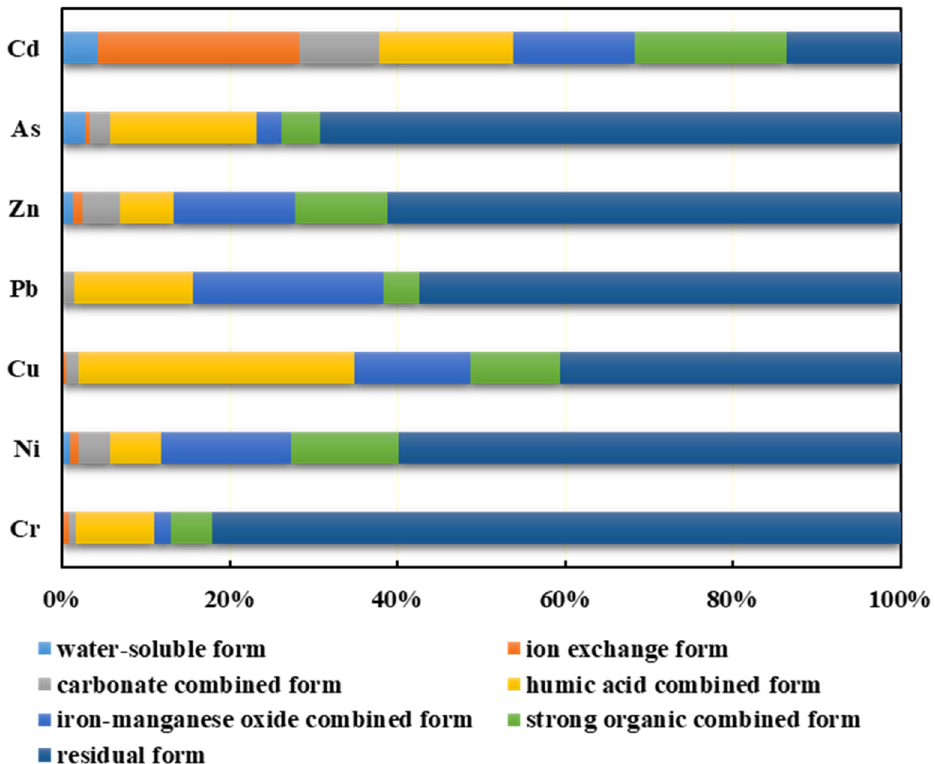
Figure 2. The proportion chart of different forms of heavy metals in the farmland soil around the Dachang mining area. Table 3. Statistical parameters of pH value, organic matter, and heavy metal content of the farmland soil around Dachang mining area.